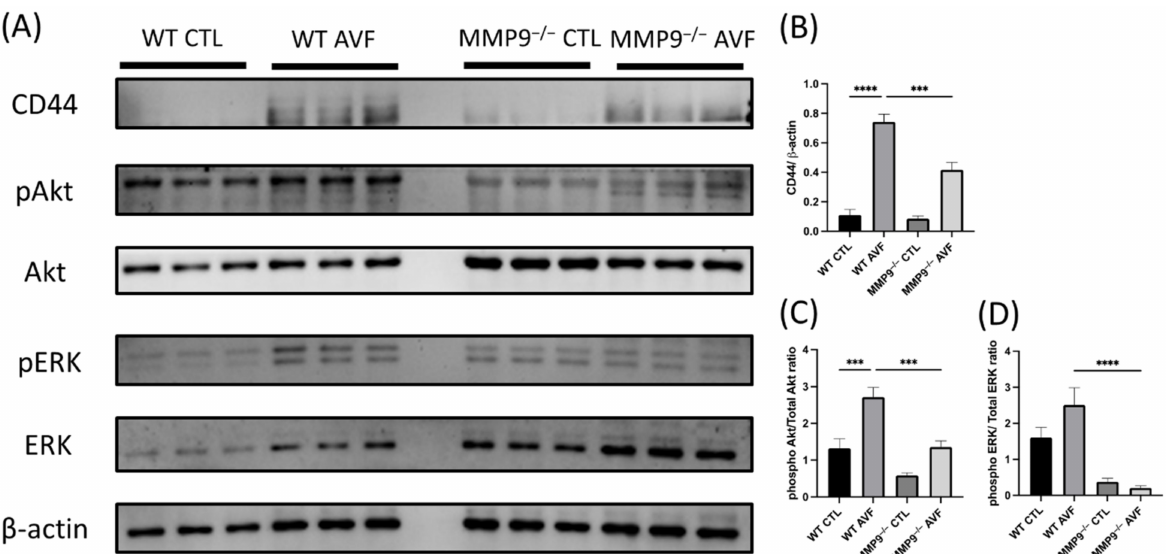
Figure 7. Matrix metalloproteinase 9 (MMP-9) knockout downregulated CD44 and RAC-alpha serine/threonine-protein kinase (Akt) and extracellular signal-regulated kinases (ERK) phosphorylation in arteriovenous (AV) fistula venous segment. ( A ) Western blotting was done for evaluating the protein expression in AV fistula venous segment. ( B ) One-week post AV fistula creation, CD44 expression was increased in wild-type (WT) mice, which was reversed by MMP-9 knockout. ( C ) Akt phosphorylation was also increased after AV fistula creation and attenuated by MMP-9 knockout. ( D ) Phospho-ERK level was significantly decreased in MMP-9 − / − mice. *** p < 0.001, **** p < 0.0001. Data presented as mean ± SEM. Data analyzed by one-way analysis of variance (ANOVA) followed by Bonferroni post hoc analysis, n = 6 in each group. CTL,